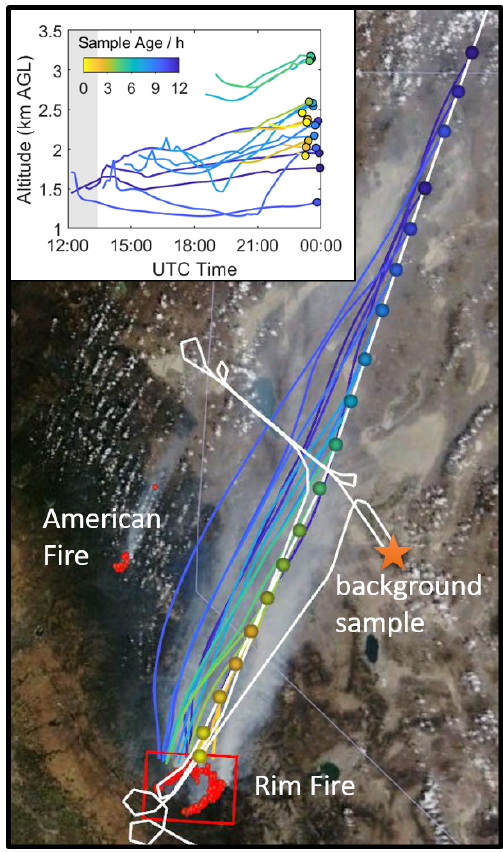
Figure 1. Map of the study region. The background shows visi- ble imagery and fire counts (red dots) from Terra/MODIS (https: //worldview.earthdata.nasa.gov/, last access: 23 January 2020). The white line is the DC-8 flight track. The aircraft entered from the south, flew over the fire, proceeded NE to do a missed approach at Fallon Municipal Airport (near orange star), executed a wall pattern of perpendicular transects at several altitudes, and returned to the fire before proceeding NE along the long axis leg. Colored circles denote the Whole Air Sampler (WAS) sample locations, and col- ored lines are the corresponding median trajectories. Yellow-to-blue shading indicates Lagrangian plume age at the time of sampling (see color bar in the inset). The orange star is the location of the back- ground sample. The red box is the Rim Fire box used for trajectory filtering. The inset shows the time series of the median trajectory altitudes with respect to ground level. Colored circles denote the observation time. The gray shaded area indicates night time.